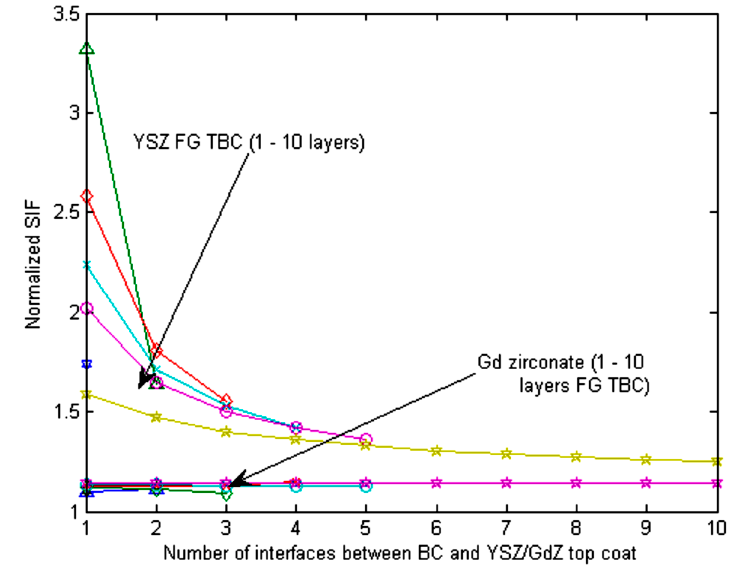
Figure 11. Comparison of normalized K 1 / K 0 as computed at the interfaces between the different graded layers in different FG TBC systems. Numbers on the x -axis refer to the number or positions of the interfaces as illustrated in Figure 10.